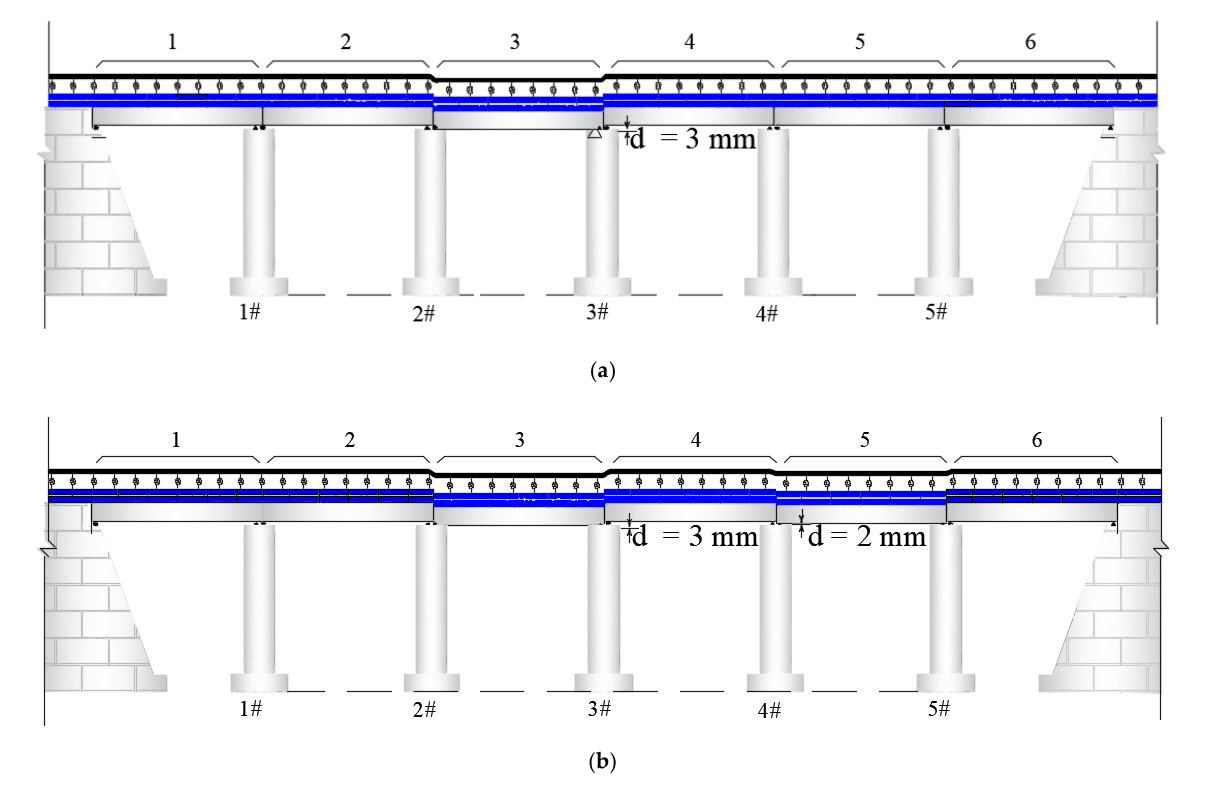
Figure 7. Deformation diagram of bridge under vertical girder fault. ( a ) The vertical fault of the single girder. ( b ) The uneven vertical fault of two separated girders.